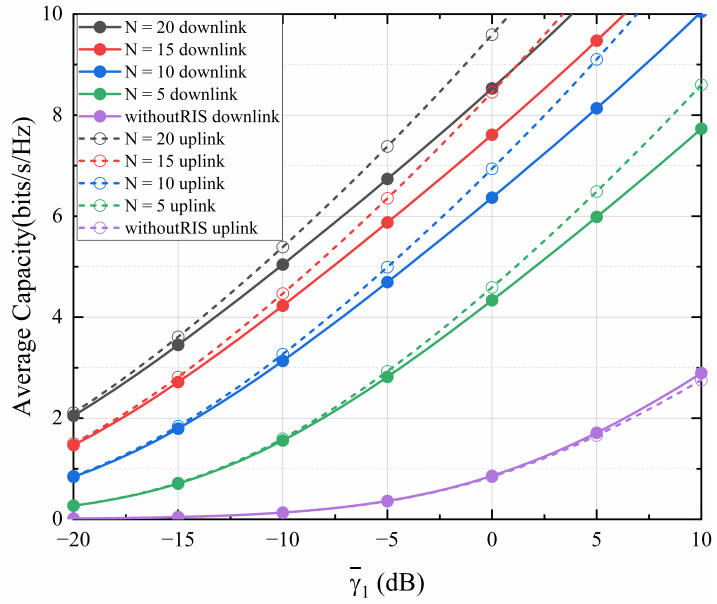
Figure 10. Average channel capacity under different N when α = 4.0, β = 1.6, ξ = 10, γ 2 = 40 dB, d = 5.0